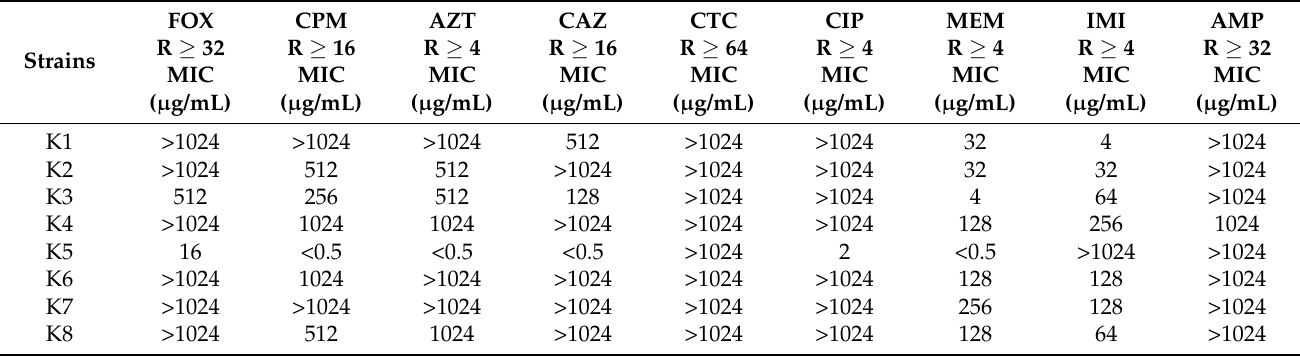
Table 1. MIC values of different antibiotics against carbapenemase-producing K. pneumoniae isolates. Antibiotic resistance (R) values were indicated according to the Clinical and Laboratory Standards Institute (CLSI) (M100-S24)